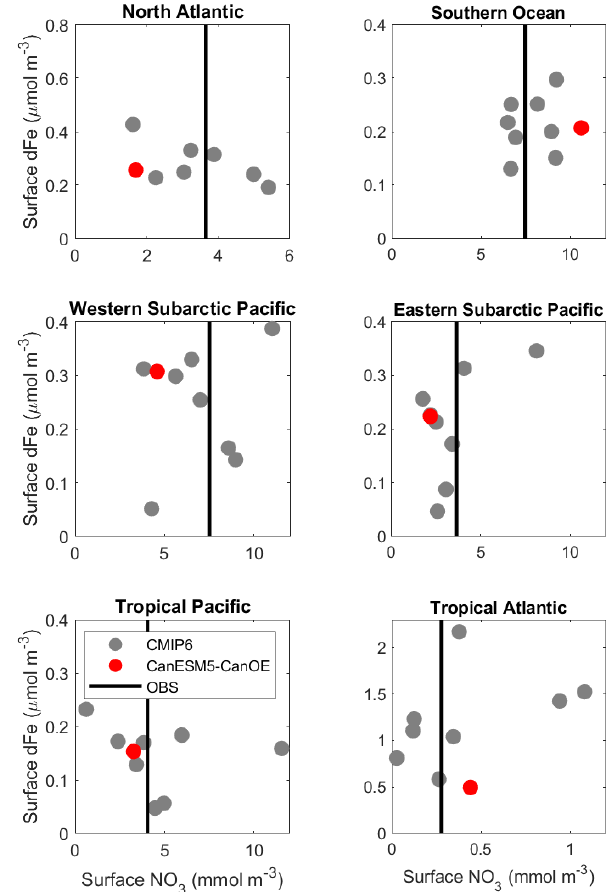
Figure 14. Mean surface nitrate (NO 3 ) vs. dissolved iron (dFe) concentrations in different oceans, including the major high- nutrient/low-chlorophyll (HNLC) regions. CanESM5-CanOE is shown as a red dot and other CMIP6 models as grey dots (CanESM5 is not included because it does not have iron). Observed NO 3 is shown as a vertical black line as there are no observational estimates of dFe concentration. For GFDL-CM4, nitrate is estimated as phos- phate × 16. Region definitions are given in Table S5 and Fig.